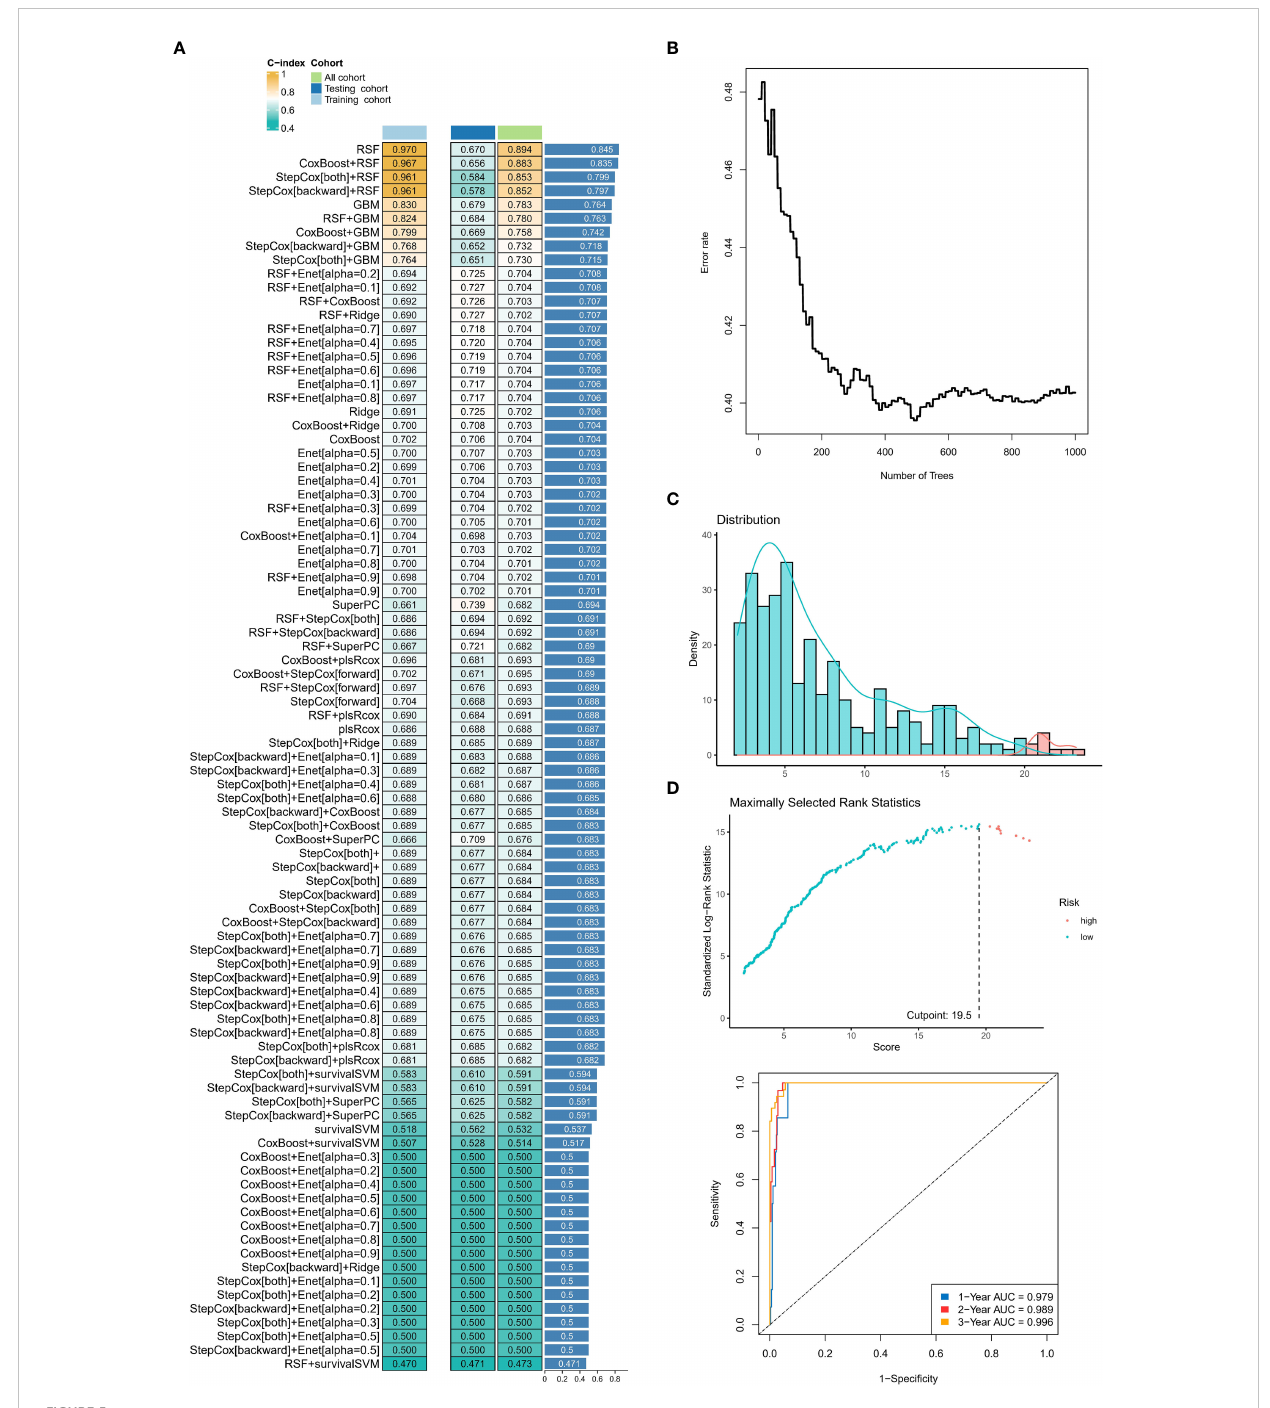
FIGURE 5 Construction and testing of the machine learning-derived prognostic signature. (A) The C-indexes of 89 machine-learning algorithm combinations in the three cohorts. (B) Error rate curve of random forest tree model. (C) The changes in AUC value of different time points. (D) The area under the ROC curve (AUC) for the 1-year, 2-year, and 3-year OS in the training cohort. ns, no statistical signi fi cance; *p < 0.05, **p < 0.01, ***p <